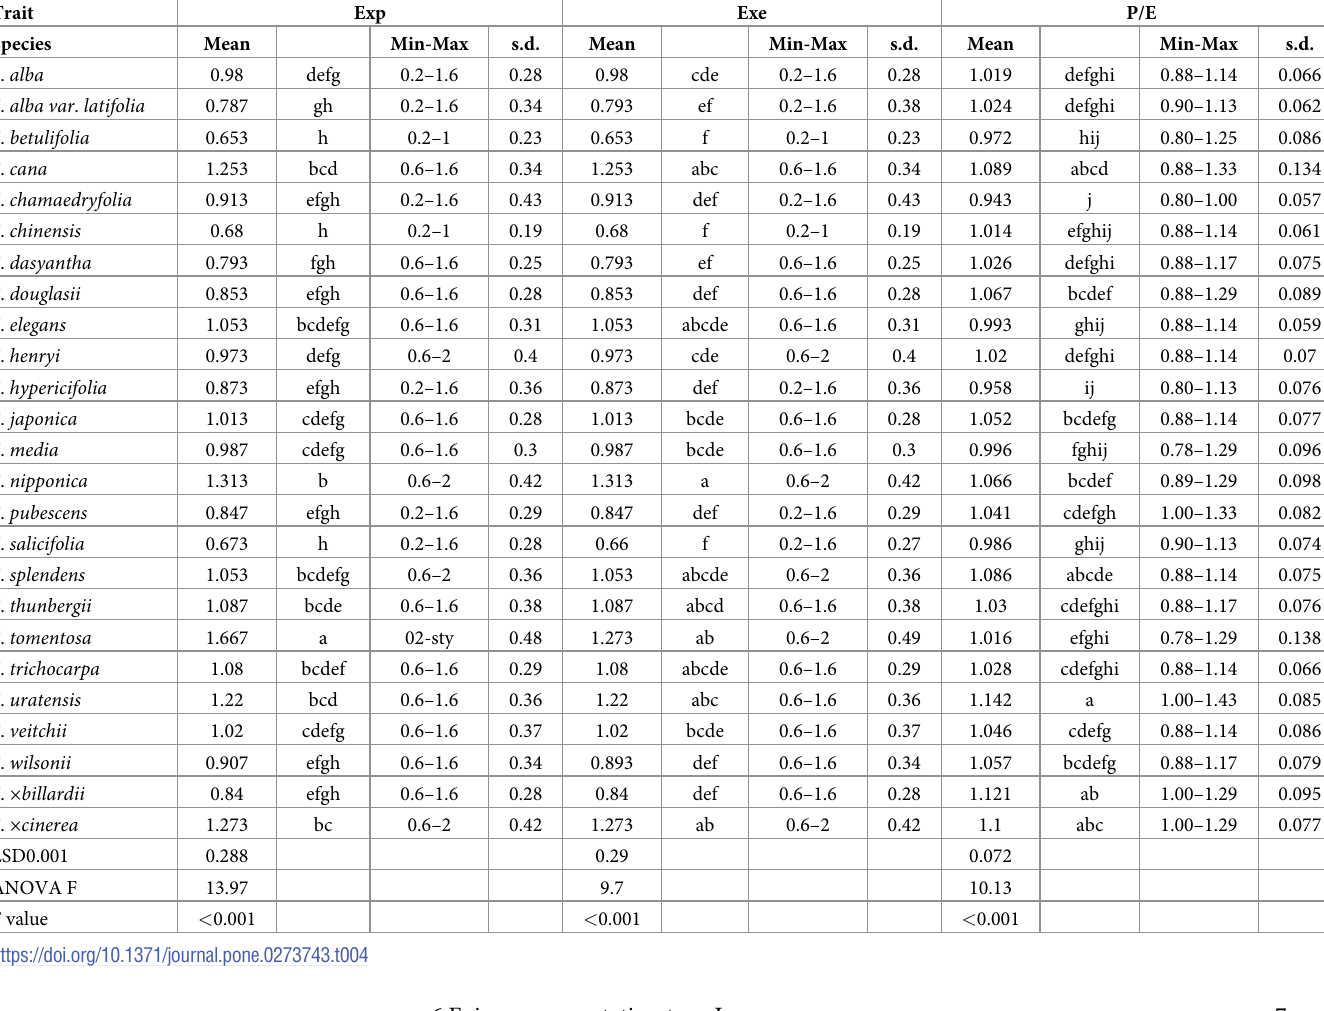
Table 4. Minimal, maximal and mean values as well as coefficients of variation (CV) for exine thickness along the polar axis (Exp), exine thickness along the equato- rial diameter (Exe) and P/E of analyzed species.